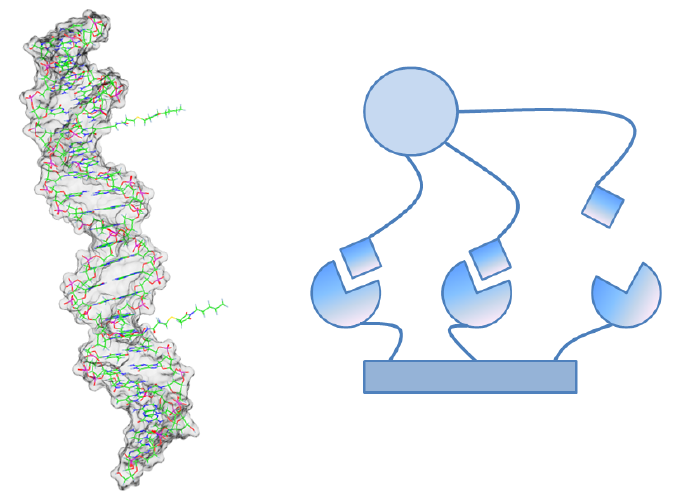
Figure 3. Left: Molecular example for a multivalent ligand based on a DNA backbone [33]. Right: In multivalent ligand-receptor complexes there exist molecular micro-states which are neither completely bound nor completely unbound. In a process with two macro-states these micro-states partially correspond to both of the macro-states. χ = X A quantifies this ratio. det ( S ) quantifies their contribution to the binding